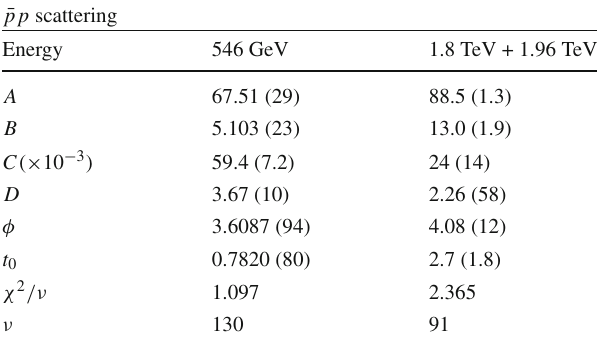
√ s = 546 GeV (left) and 1.8 TeV (right) and Table 3 Results for the fits of the differential cross section data con- sidering ¯ pp collisions. The reduced χ 2 and degrees of freedom, ν , for each fit are also